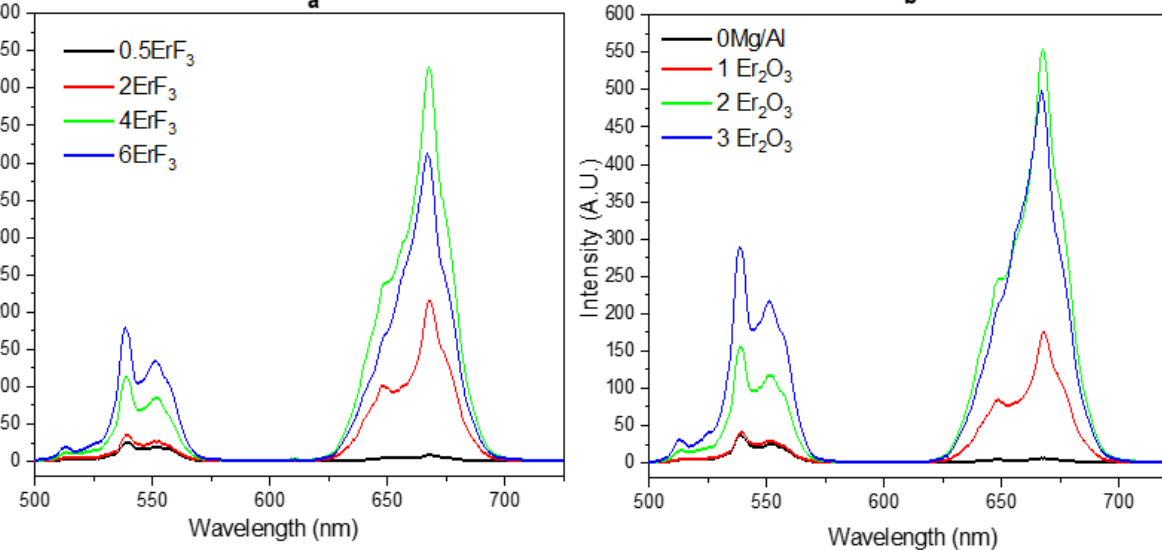
Figure 7. Upconversion spectra of the glasses prepared with ErF 3 ( a ) and Er 2 O 3 ( b ) after heat-treatment at (T g + 20 °C) for 17 h and at T p for 1 h ( λ exc = 975 nm). Note that the 0Mg/Al corresponds to 0.25Er 2 O 3 glass.